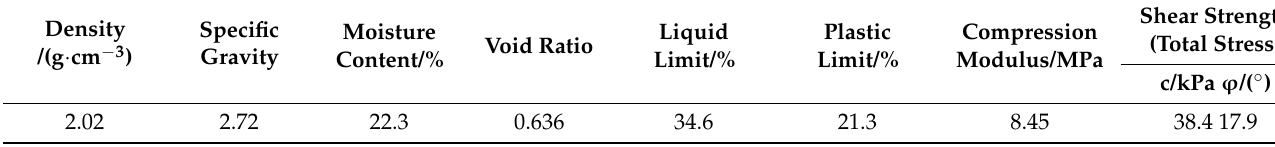
Table 2. Physical and mechanical indexes of expansive